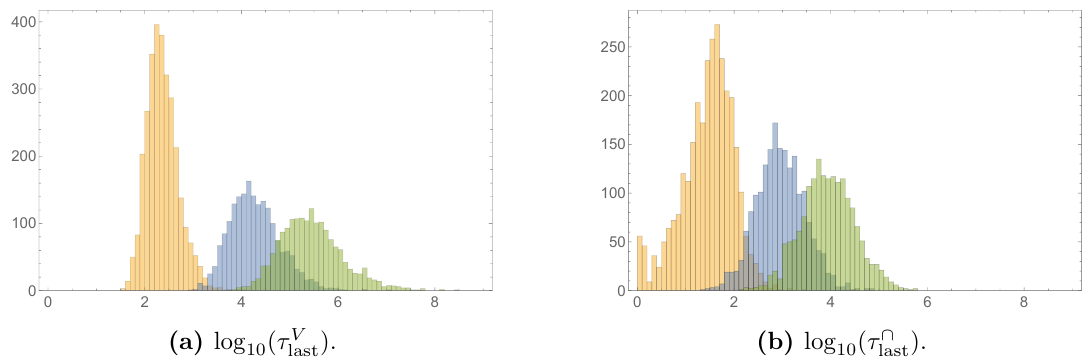
, de(cid:12)ned in (4.25), vs. h 1 ; 1 . last